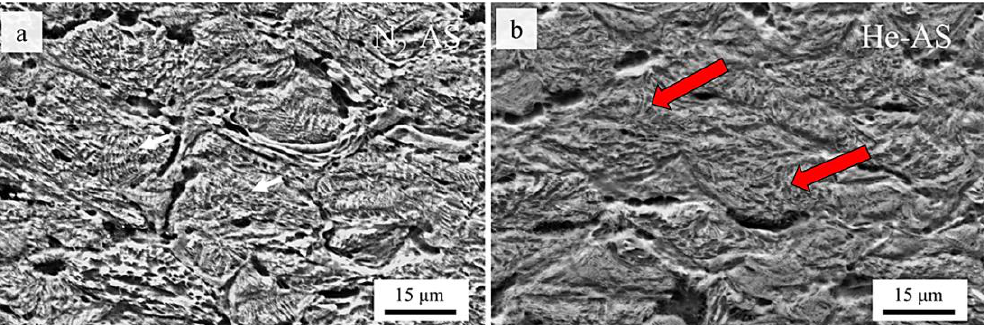
Figure 8. Cross-section morphologies of CS-deposited IN 718 ( a ) sprayed with nitrogen propellant at 7 MPa and 1000 °C and ( b ) sprayed with helium propellant at 3 MPa and 1000 °C with the red arrows indicating the presence of a dendritic-based structure. Adapted from Ma et al. [78], Copyright 2019, with permission from Elsevier.